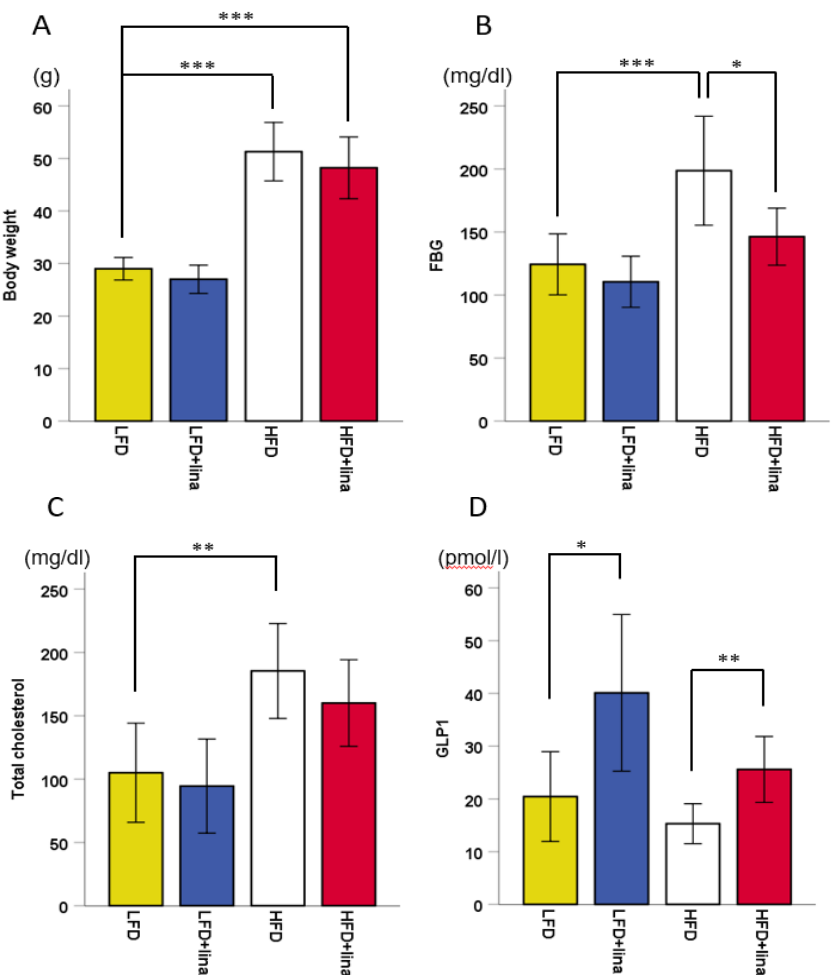
Figure 1. E ff ects of linagliptin (10 mg / kg BW / day) on ( A ) body weight, ( B ) fasting blood glucose (FBG), Figure 1. Effects of linagliptin (10 mg/kg BW/day) on (A) body weight, (B) fasting blood glucose ( C ) total cholesterol, and ( D ) glucagon-like peptide-1 (GLP-1) in PS19 mice being fed a low-fat diet (FBG), (C) total cholesterol, and (D) glucagon-like peptide-1 (GLP-1) in PS19 mice being fed a low-fat (LFD) or high-fat diet (HFD) for approximately 6 months. Mean ± SD. One-way ANOVA, followed